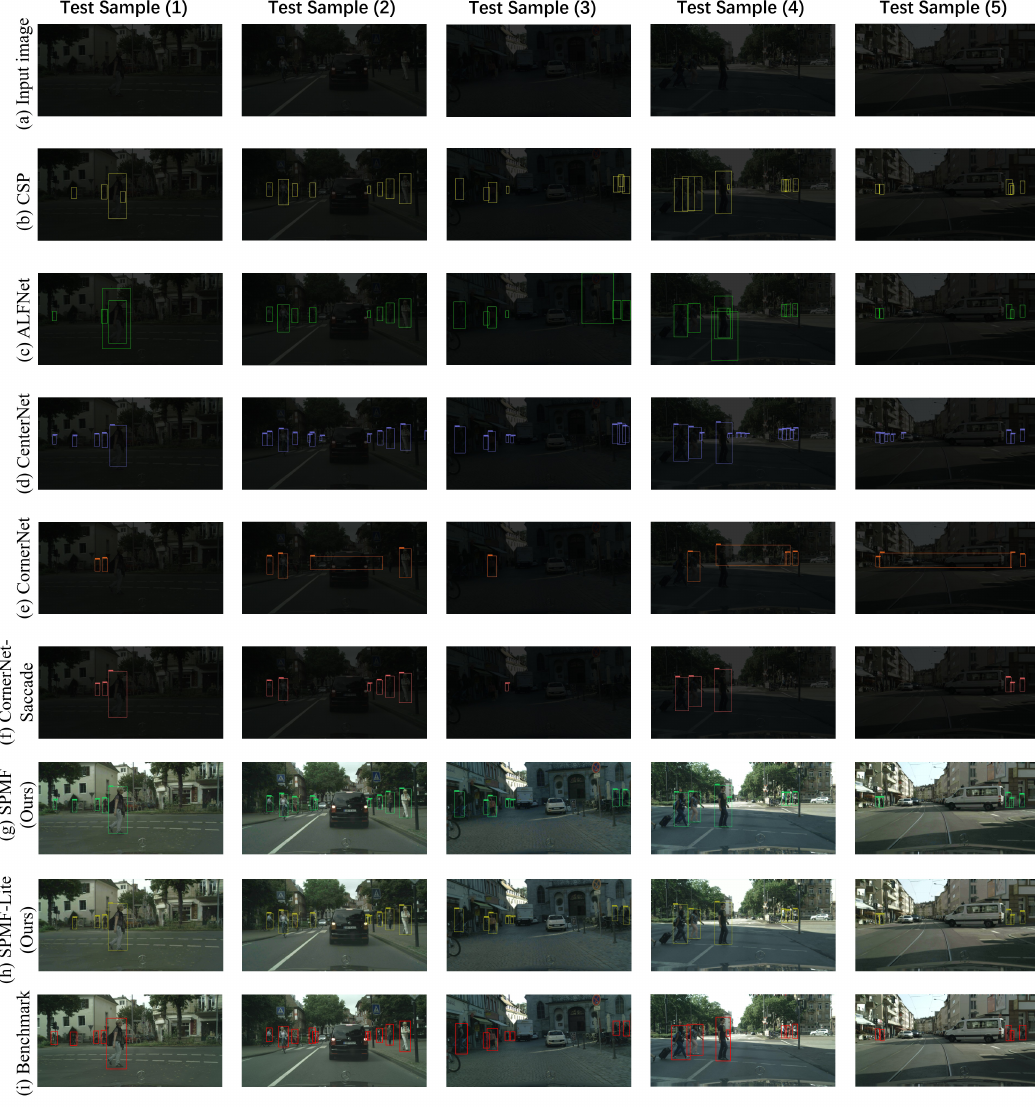
Figure 5. Visual results (end-to-end testing mode) from the different detection methods. Five images from the low-light CityPersons testing set is selected as the samples to show the detected results (with marked bounding box in different color).